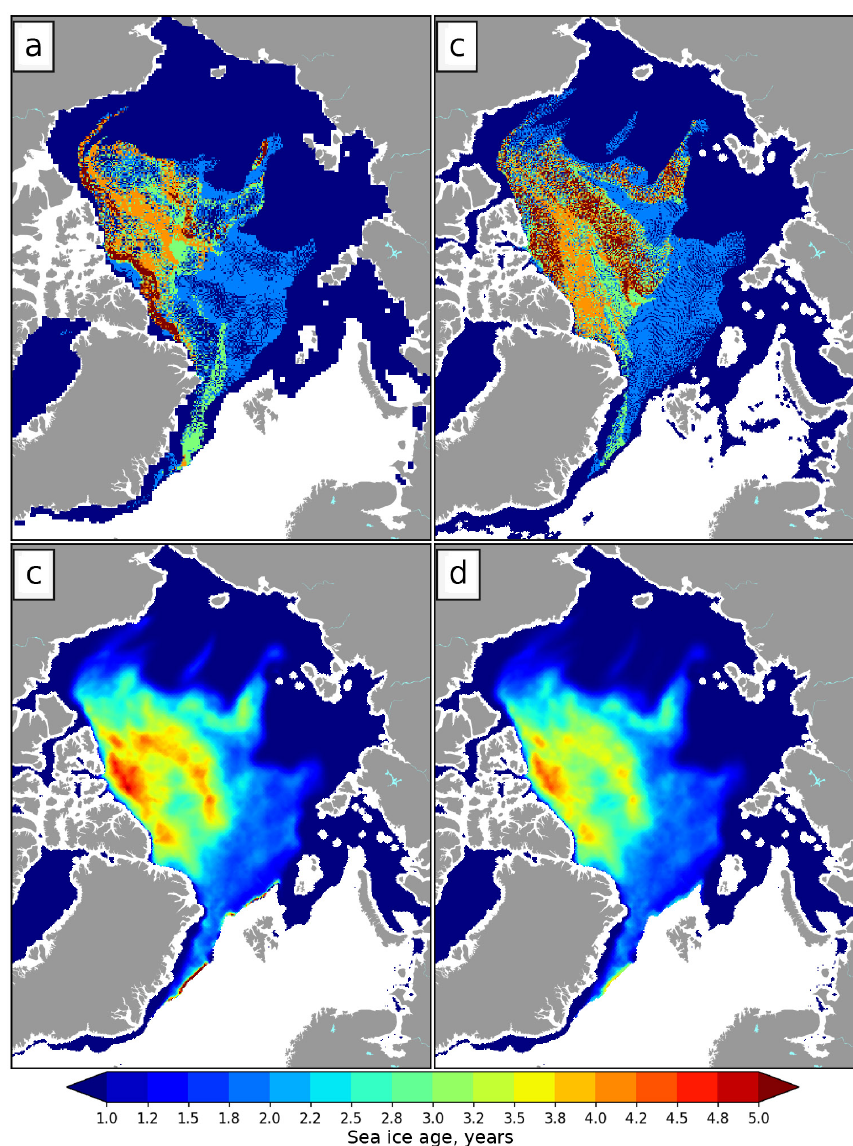
Figure 6. Comparison of SIA for the 1 January 2016 calculated with the following combinations of forcings and algorithms: (a) NSIDC drift and NSIDC algorithm; (b) OSI SAF drift and NSIDC algorithm; (c) OSI SAF drift and SICCI algorithm without SIC; (d) OSI SAF drift and SICCI algorithm with